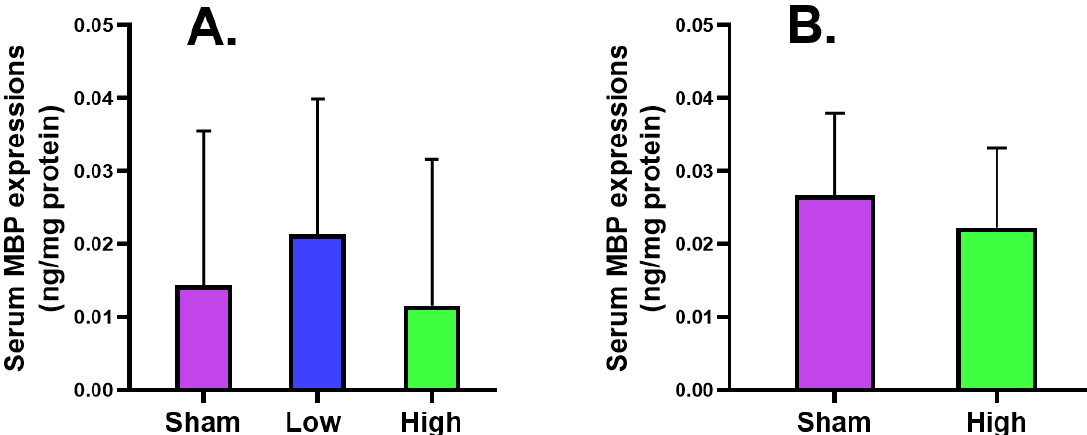
Figure 3. Effect of tDCS-iTBS on serum MBP expressions (ng/mg protein): ( A ) short-term ( n = 15) and ( B ) long-term stimulations ( n = 16).